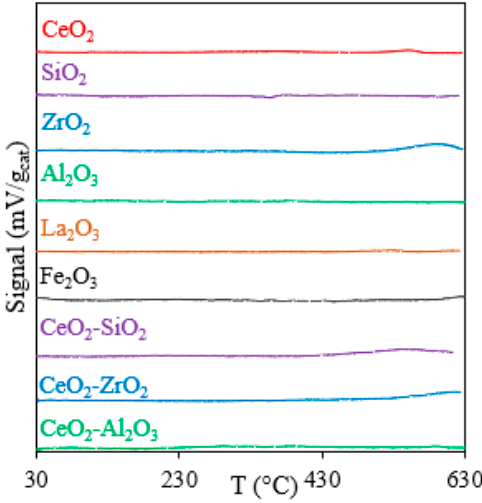
Figure A3. H 2 -TPR profiles of bare supports evaluated in the CO removal from an actual syngas.